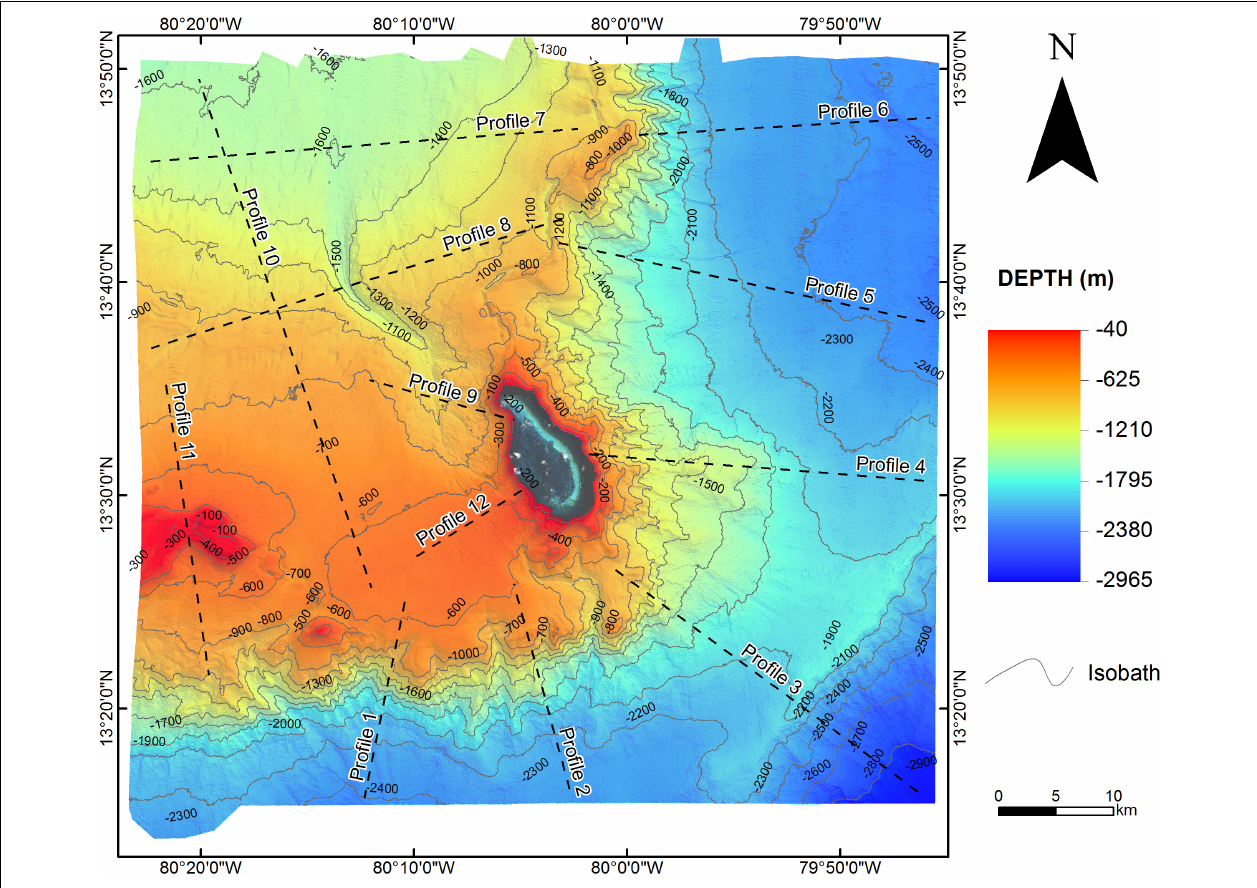
FIGURE 2 | Bathymetric model, with gray scale hillshade behind, of Roncador Bank and adjacent areas. The sector exhibiting the greater depths ( > − 2,000 m) is observed to the south and east of the study area, whereas the shallower depths ( < − 2,000 m) predominate in the central and northwestern sectors. The black dashed lines indicate the profiles shown in Figure 9 . The isobaths spacing is 100 m. The satellite image covers the reef constructions shallower than –40 m and the permanently emerged areas (cays).